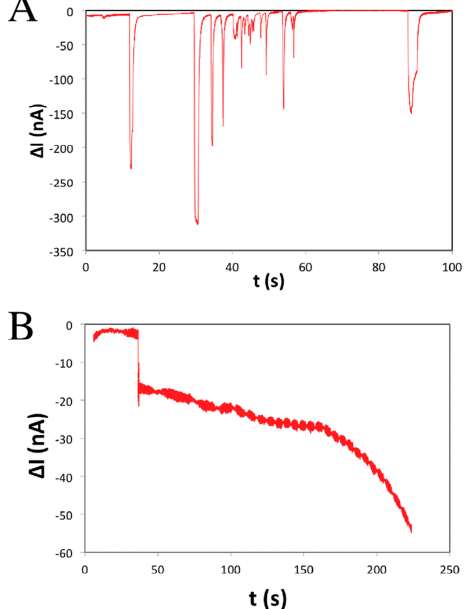
Figure 8. Typical current versus time traces of ODN-coated polystyrene (PS) particles passing through an ODN-functionalized micropore. ( A ) Translocation of non-complementary (nc)-ODN-PS. ( B ) Capture of complementary (c)-ODN-PS.